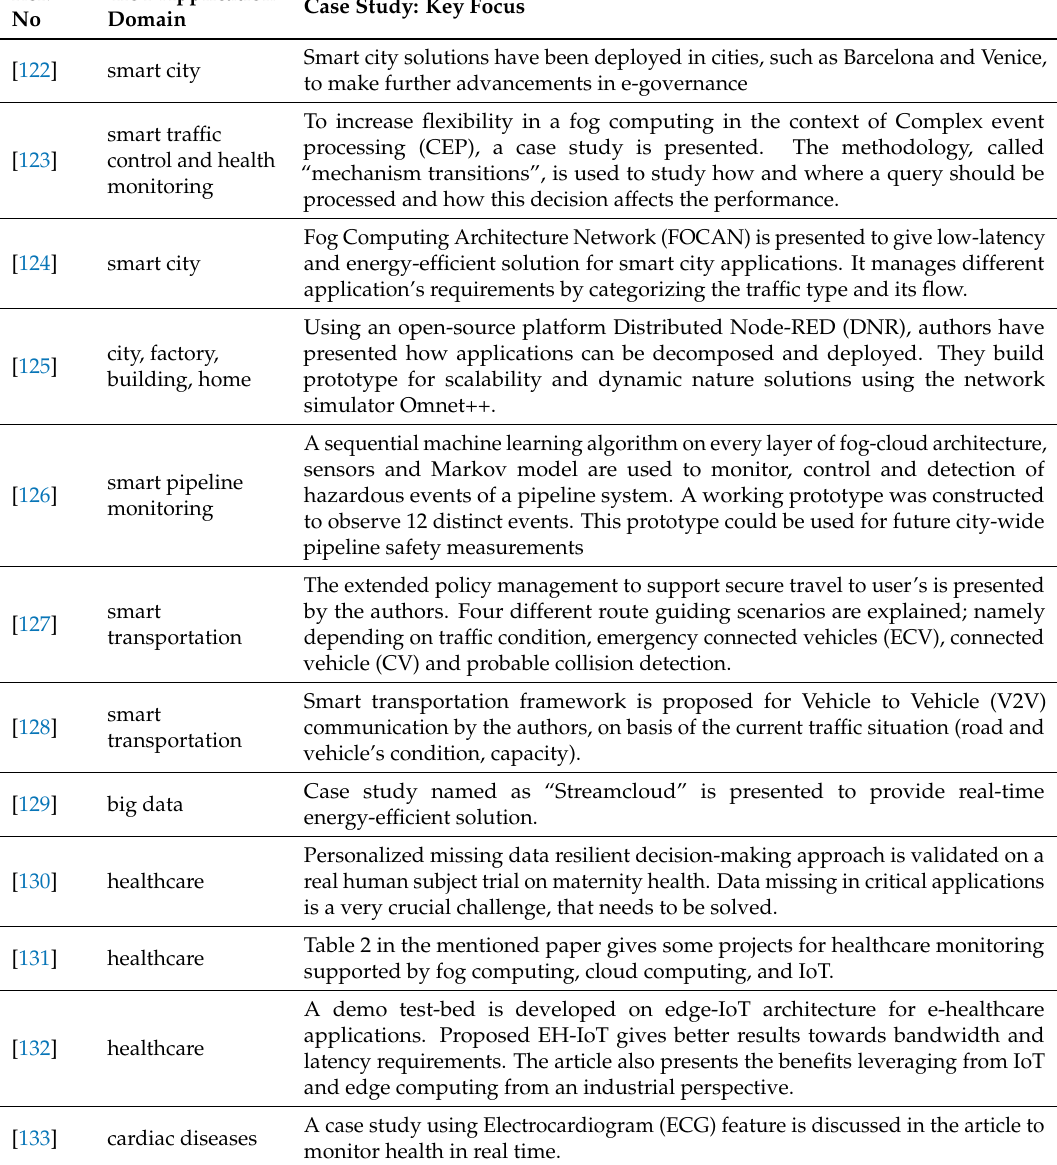
Table 2. Case studies, Fog Computing as an